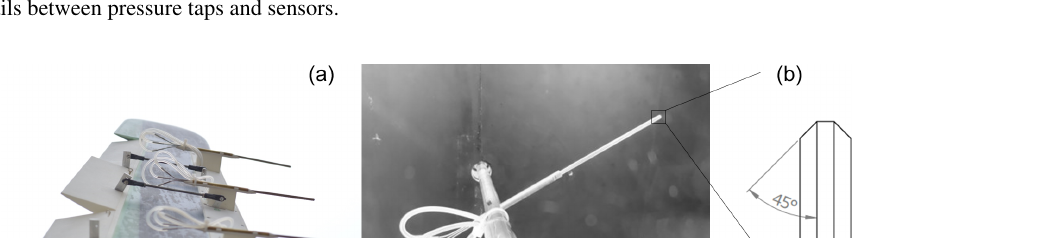
Figure 5. Tubing details between pressure taps and sensors.